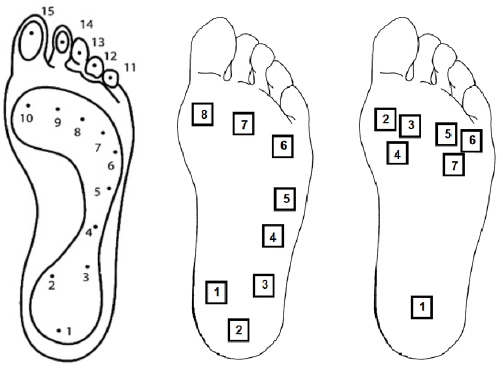
Figure 2. ( left ) Foot pressure points, ( middle ) Sensors location (v1), ( right ) Sensors location